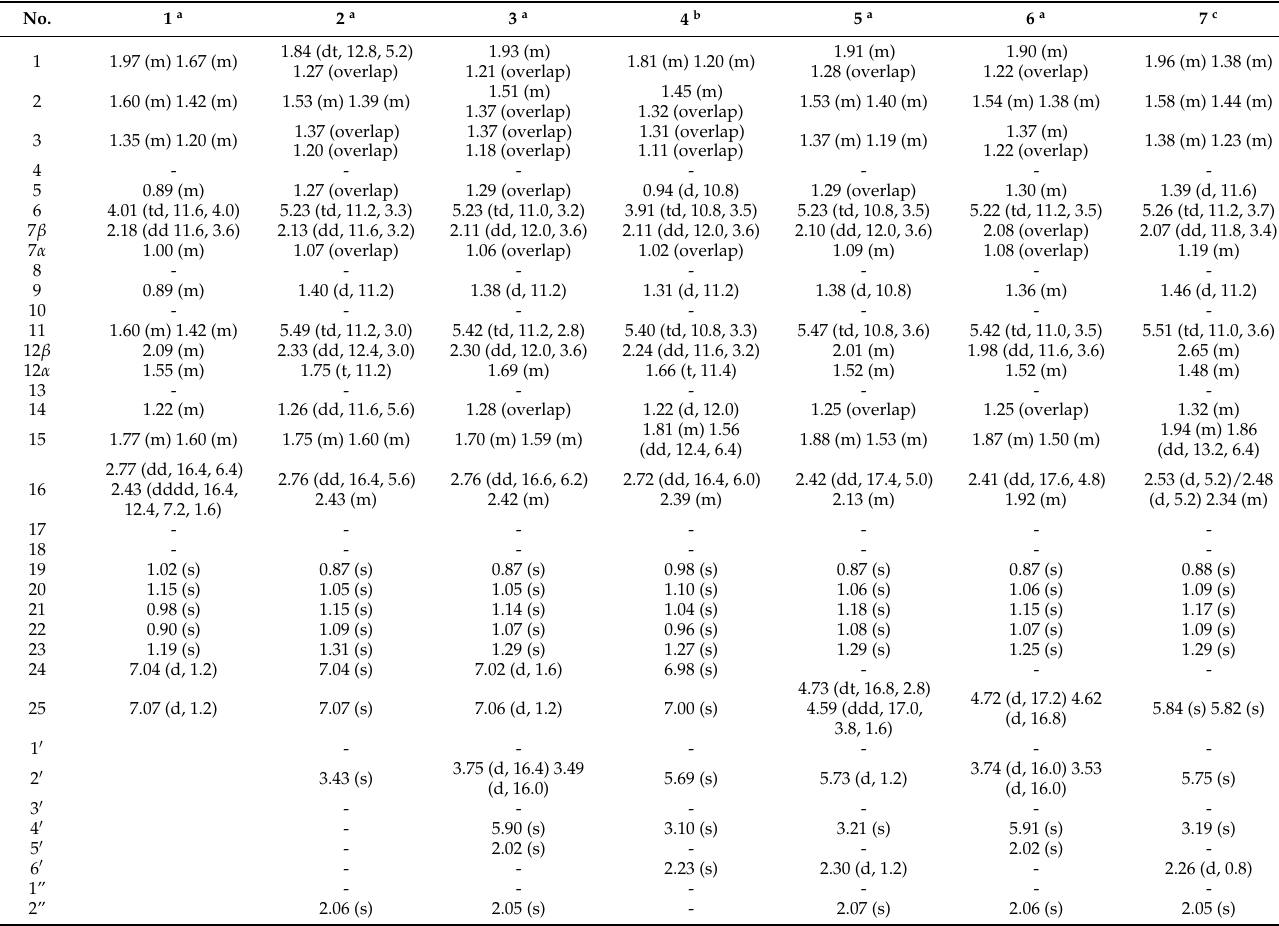
Table 1. 1 H NMR (400 MHz) data for compounds 1 – 7 ( δ in ppm and J in Hz).